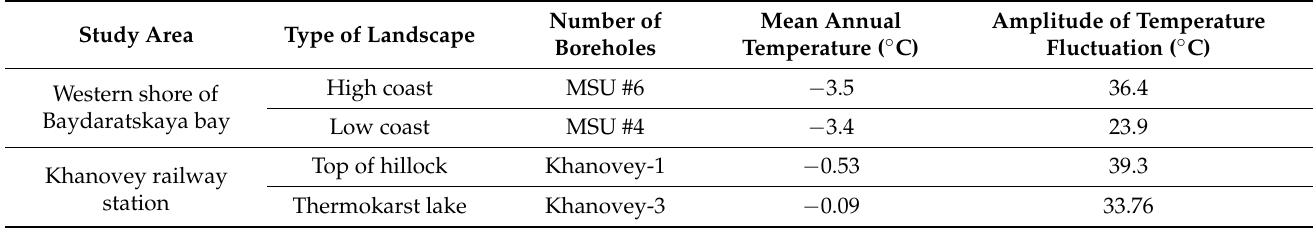
Table 1. Results of the mean annual temperature and amplitude of temperature fluctuation.